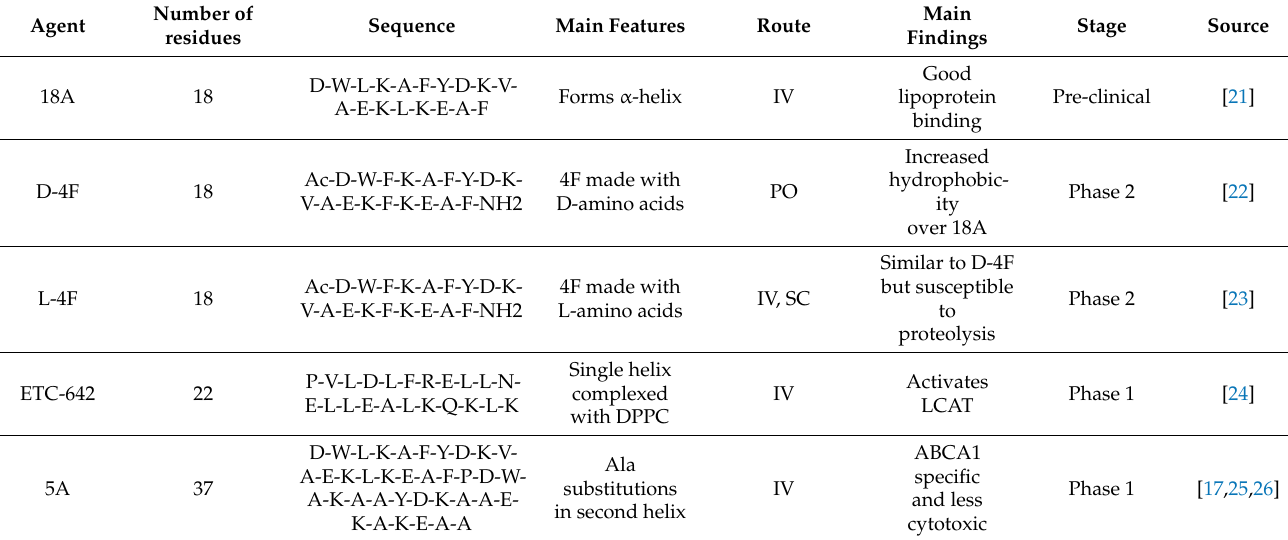
Table 2. ApoA-I mimetic